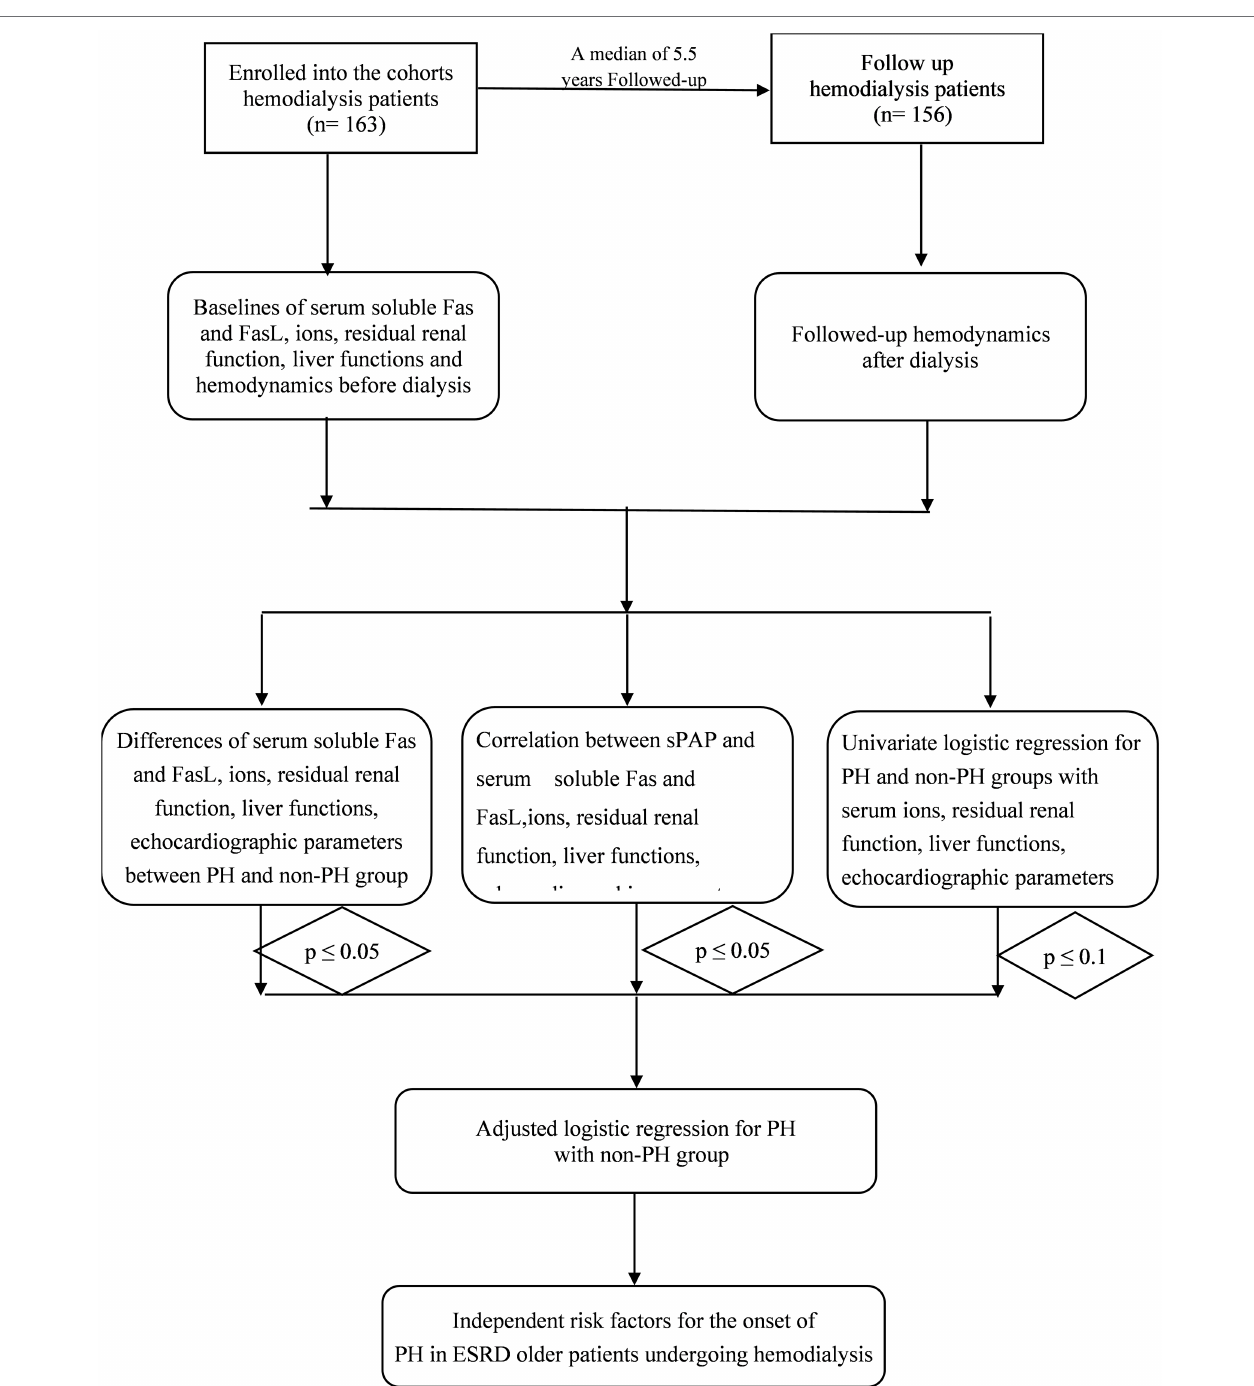
FIGURE 1 | The statistics follow chart of this